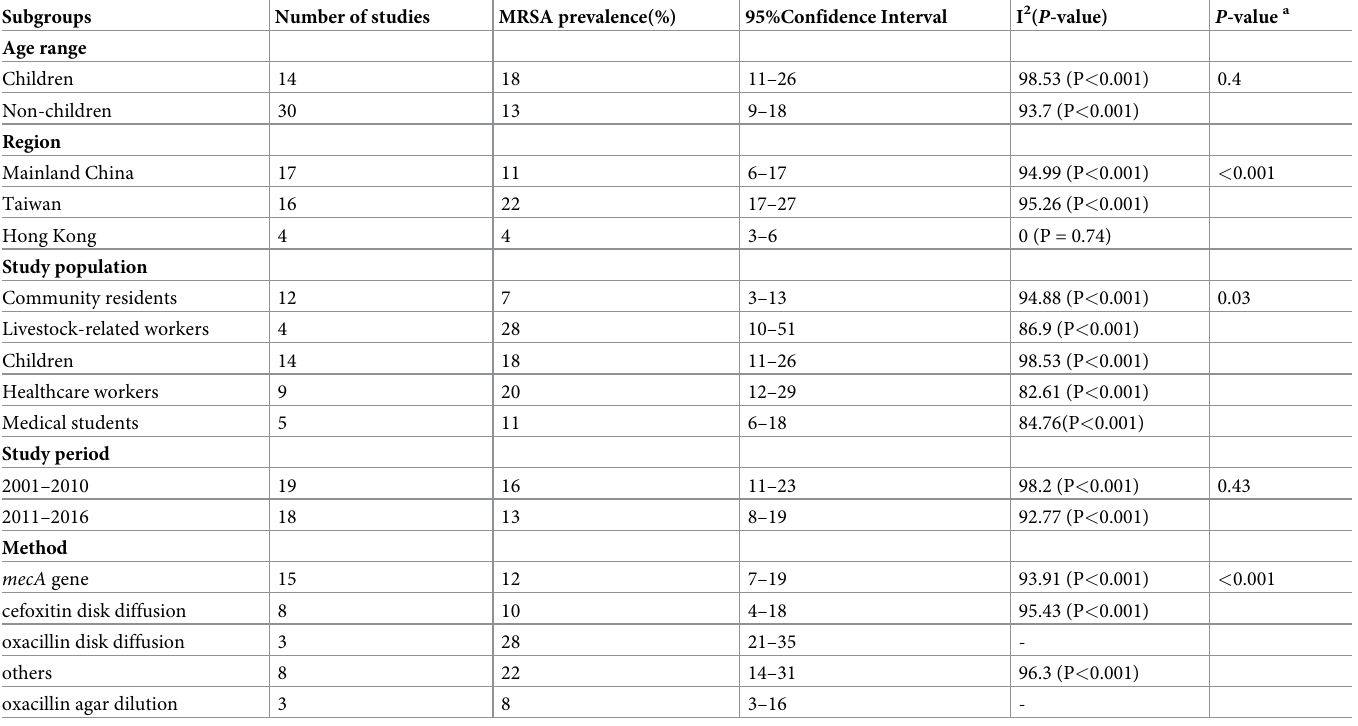
Table 2. Pooled prevalence of MRSA among S. aureus estimates by